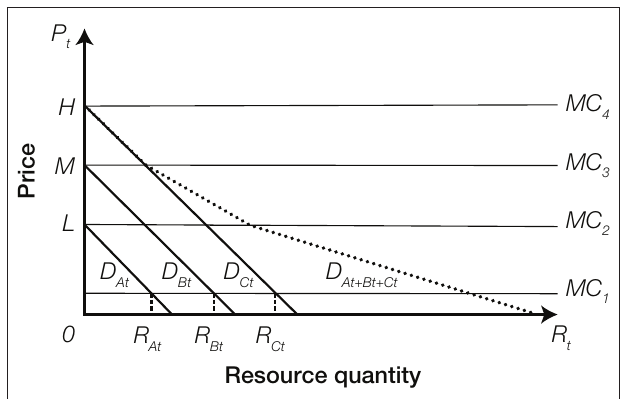
FIGURE 1 | Scarcity and equity problems in intragenerational resource